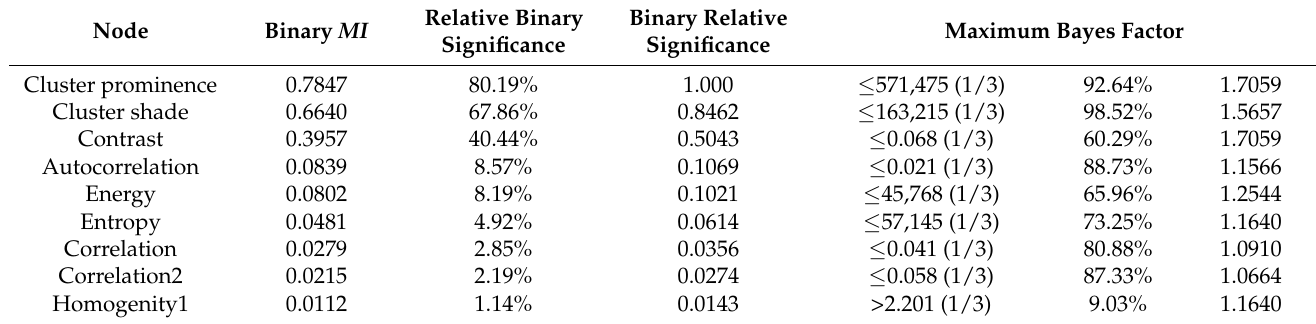
(cid:16) (cid:17) 1 58.62%. 3